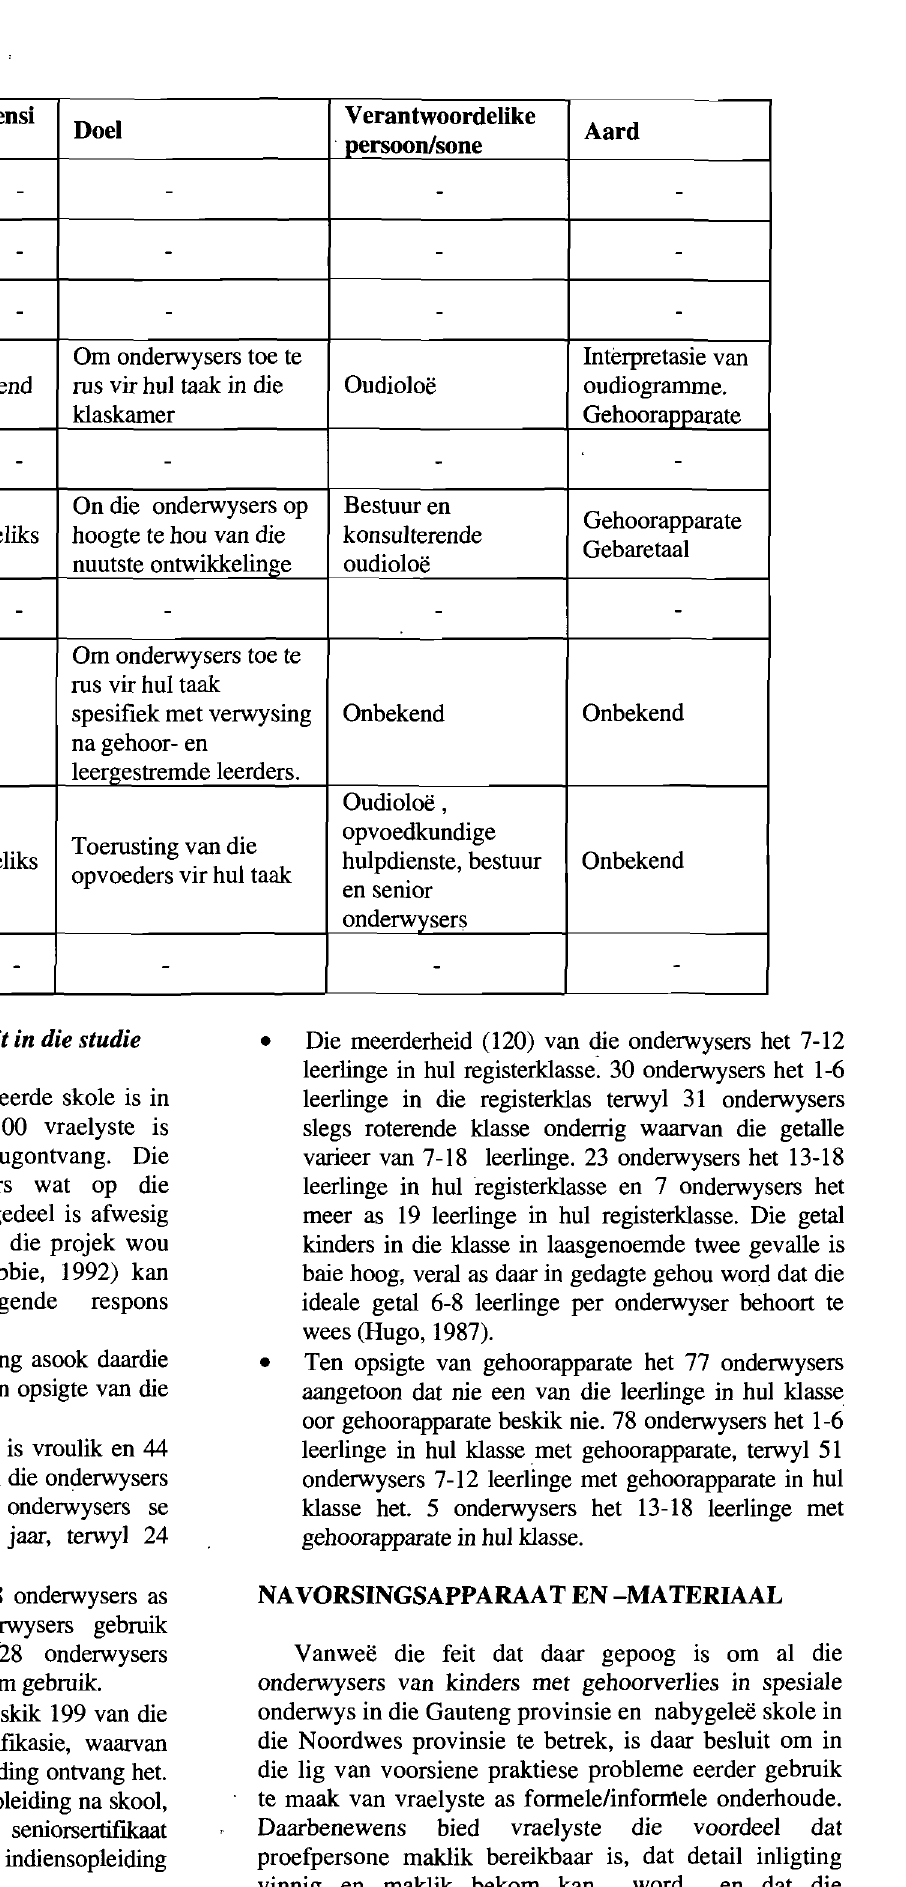
Tabel 4: Indiensopleiding in die